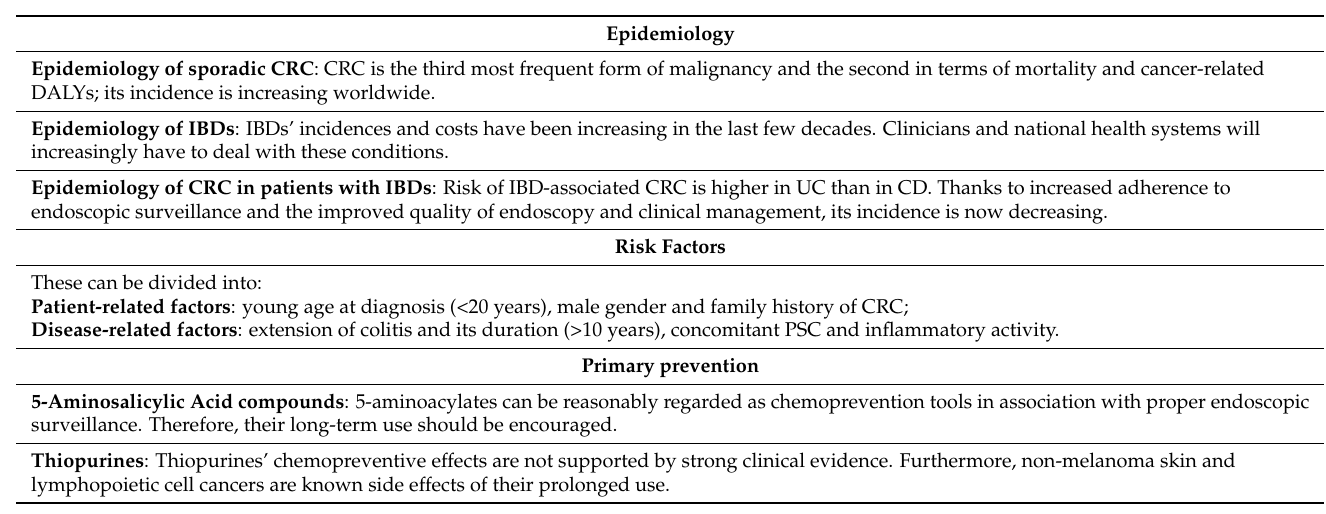
Table 3. Epidemiology and prevention of CRC in IBDs; key messages divided per